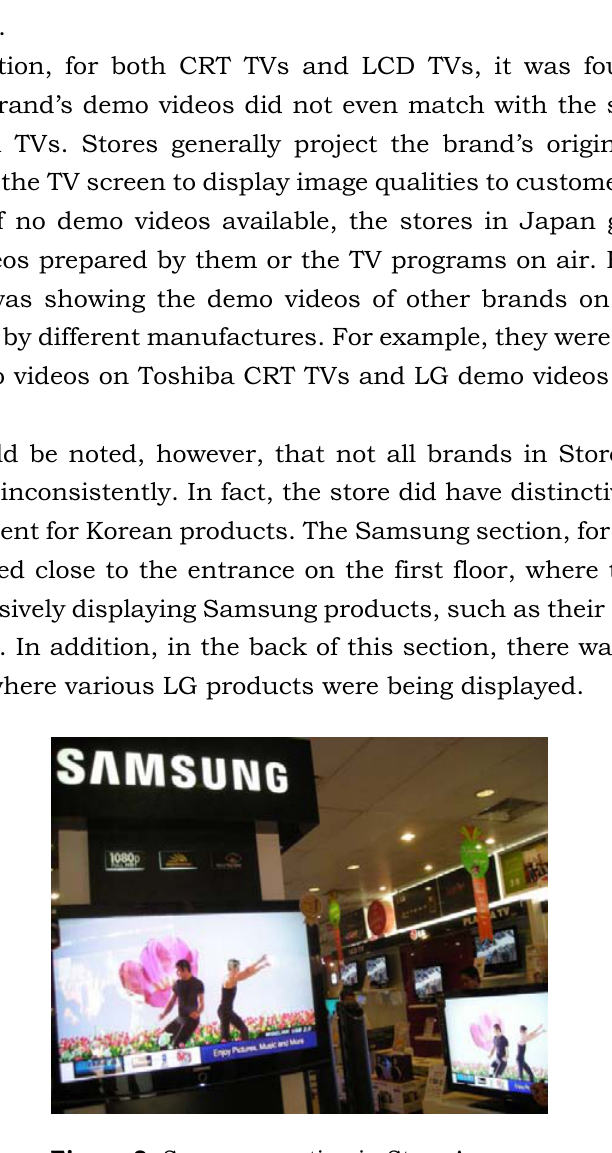
Figure 3. Samsung section in Store